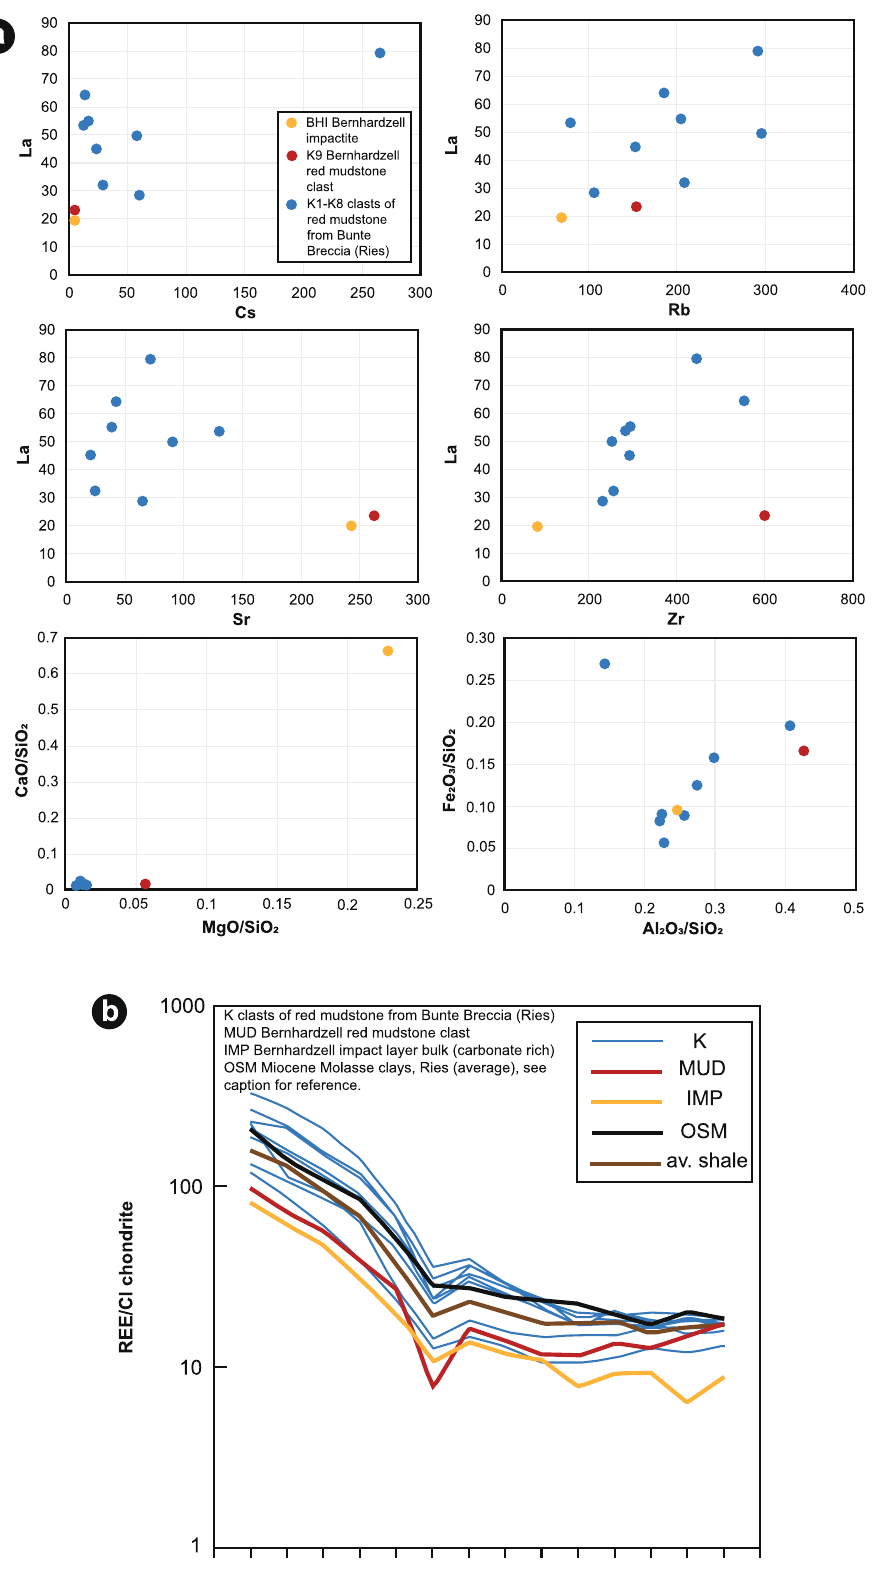
Figure 6. ( a ) Whole-rock geochemical plots showing the variations in La, Cs, Rb, Sr, Zr, CaO, SiO 2 , MgO, Fe 2 O 3 , and Al 2 O 3 for the Bernhardzell samples compared with samples from the Ries. ( b ) REE plot of Blockhorizont samples compared with samples from the Ries. Data for Miocene Molasse clays from Ries were obtained from Ref. 65